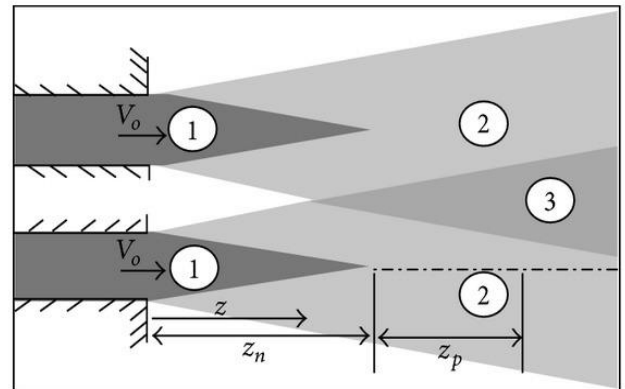
Figure 14. Twin jet configuration.